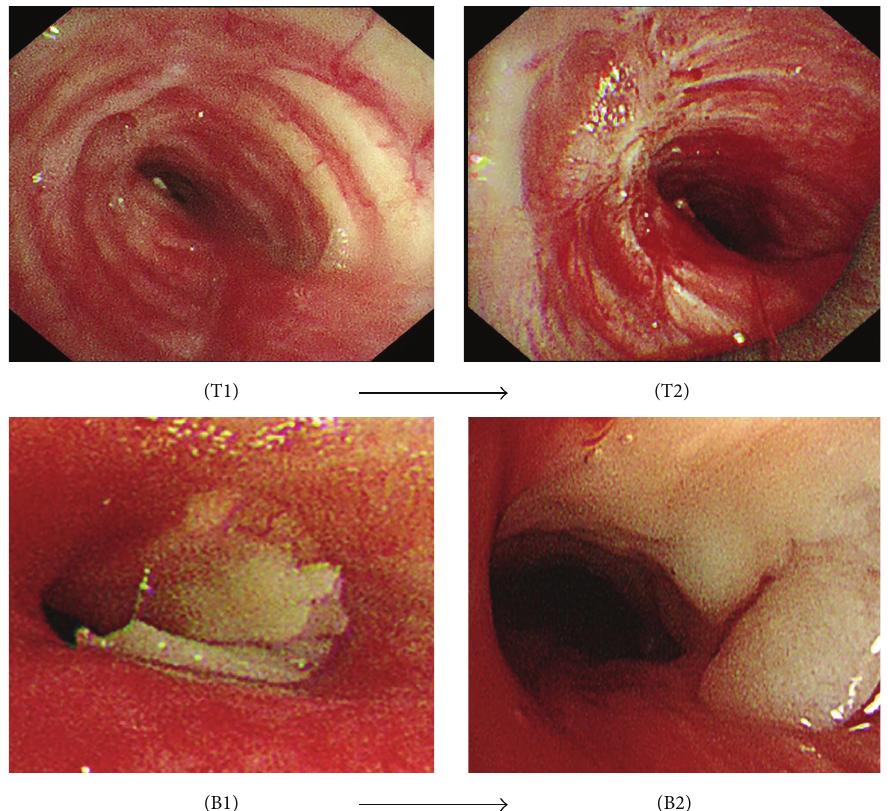
Figure 2: (T1) Distal tracheal stenosis, before ballooning. (T2) After ballooning. (B1) Left main bronchus stenosis, before ballooning. (B2) After